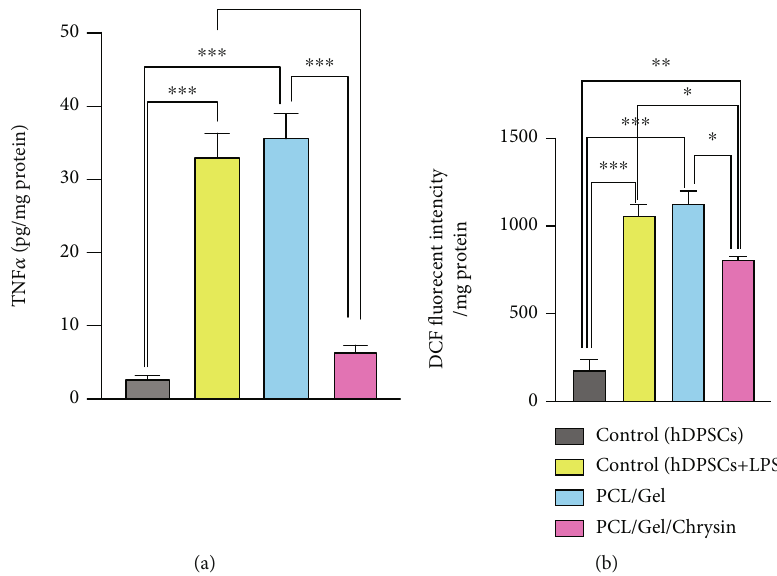
Figure 7: (a) Anti-in fl ammatory e ff ects of PCL/Gel/Chrysin sca ff olds on in fl amed DPSCs induced by lipopolysaccharide (LPS). (b) Antioxidant e ff ects of PCL/Gel/Chrysin on in fl amed DPSCs induced by lipopolysaccharide (LPS). Data were reported as the mean ± SD ( ∗ p < 0 : 05 , ∗∗ p < 0 : 01 ).